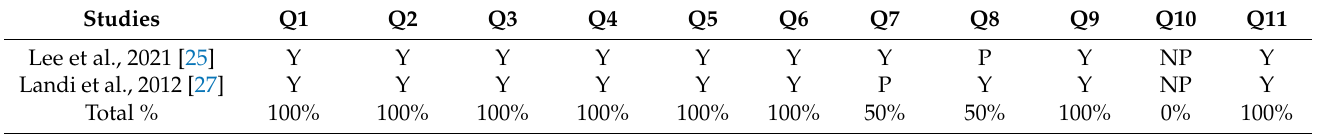
Table 5. Critical evaluation of the longitudinal studies included, S ã o Paulo, SP, Brazil,